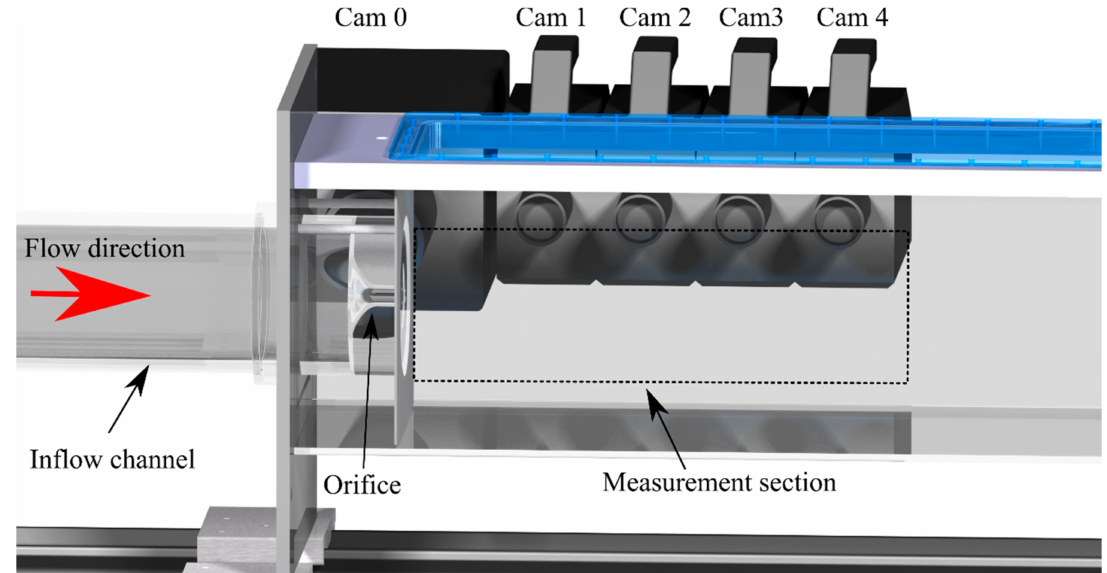
Figure 5. Sketch of the experimental setup at the scale of M50 for the high-speed measurements to measure the full break-up